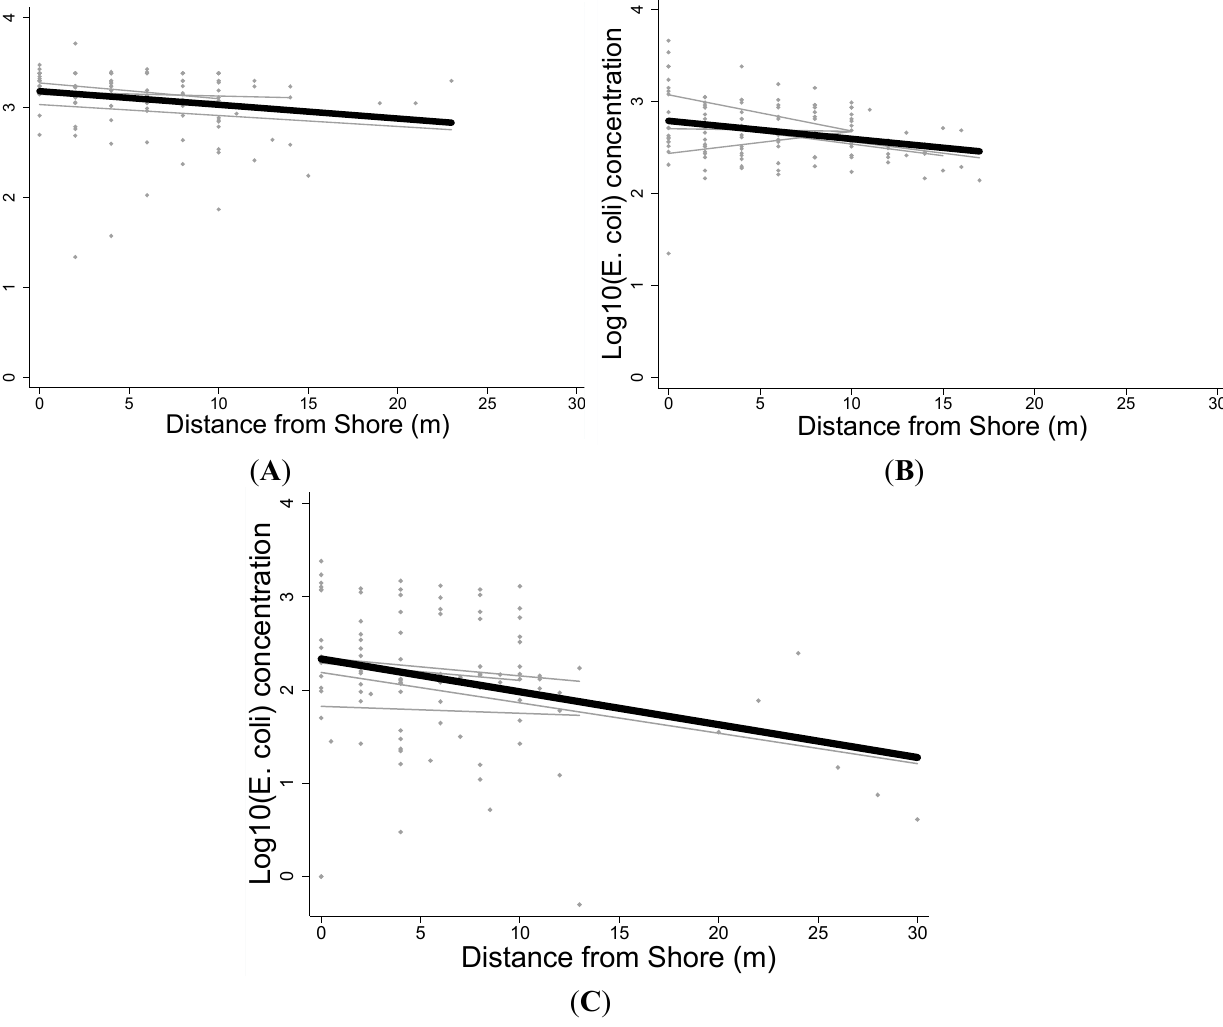
Figure 2. Log 10 E. Coli concentration versus distance from shore. Best-fit lines are shown for each transect (light grey) and for each river (black) for the ( A ) Onzole; ( B ) Cayapas; and ( C ) Santiago Rivers in northern coastal Ecuador. The relationships were significantly inversely associated for all rivers ( p <